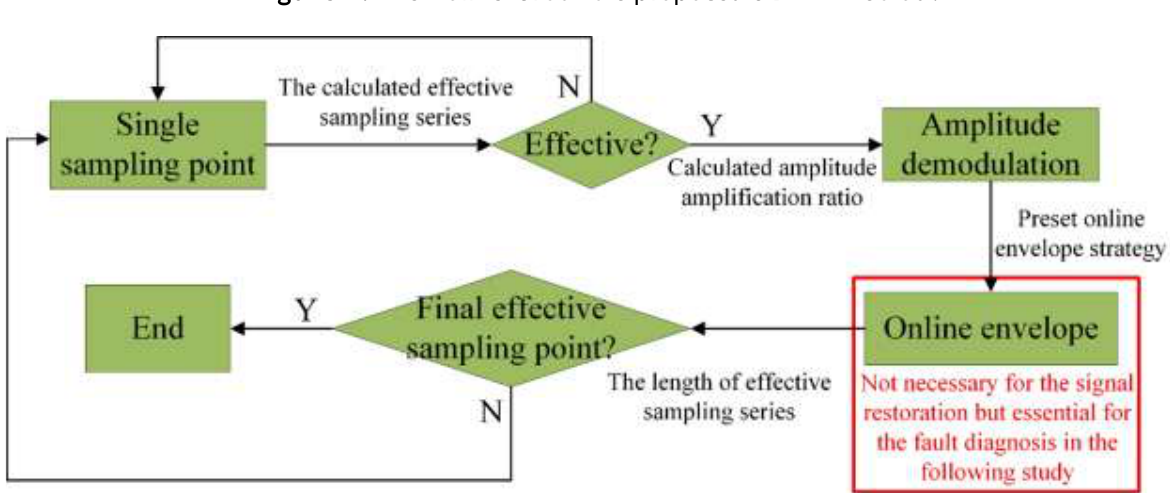
Figure 3. The process of each sampling point with the ODEE